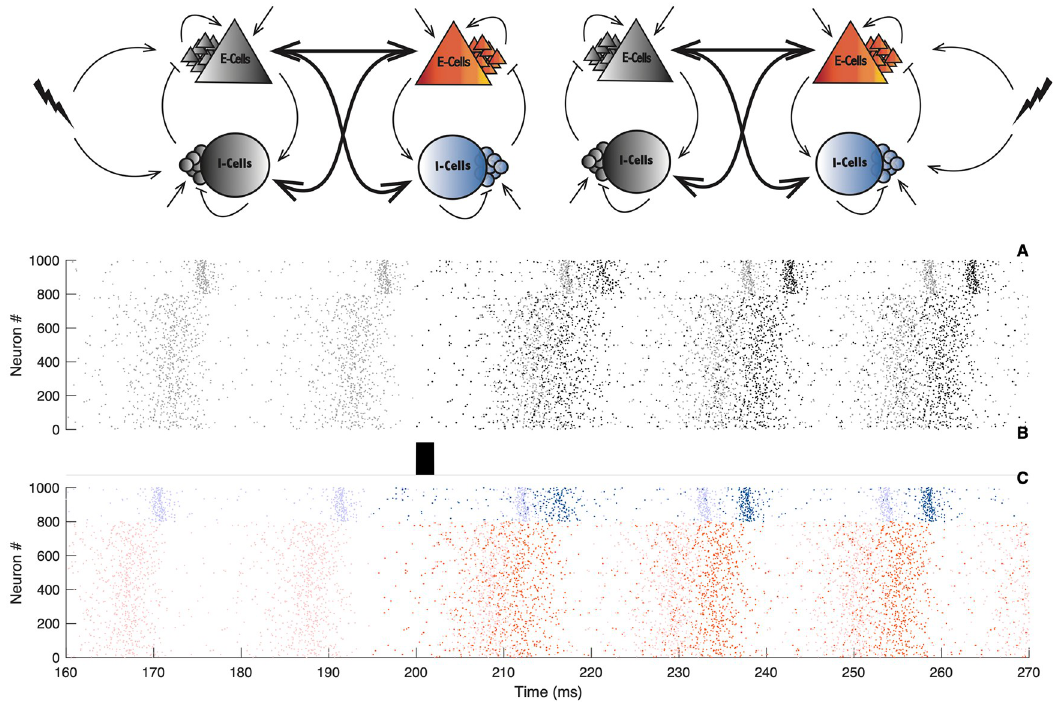
Fig 8. Illustration of the global phase shift. Upper panels: Schematic illustration of the bi-directional coupled spiking neural networks, in grey, the leader, in color, the follower. The leader is defined as spiking early in the global firing cycle, the follower spikes a delay later. The lightning bolt symbolises incoming perturbation on the leader (left panel) or on the follower (right panel). Lower panels: A) Spiking activity of the leader, the transparent spiking activity refers to the unperturbed case, the black dots refer to the perturbed scenario. B) Illustration of the incoming stimulus. C) Spiking activity of the follower, the transparent spiking activity refers to the unperturbed case, the color dots refer the perturbed network. The figure is a cartoon and does not refer to a real simulation. With the presence of the delay across circuits and weak coupling between the circuits, several cycles need to occur before the effect of a perturbation on one of the network can be perceived on the other